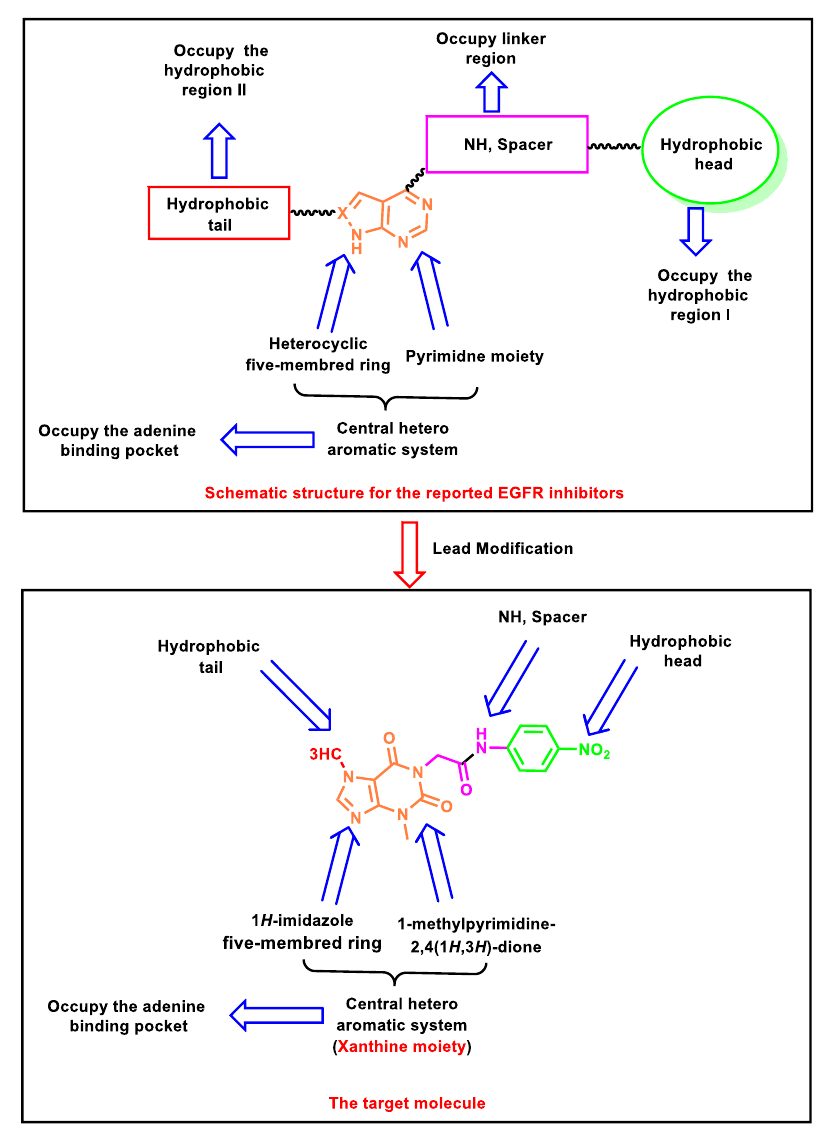
Figure 2. The rationale for the molecular design of T-2-PNPA as a potential EGFR inhibitor.